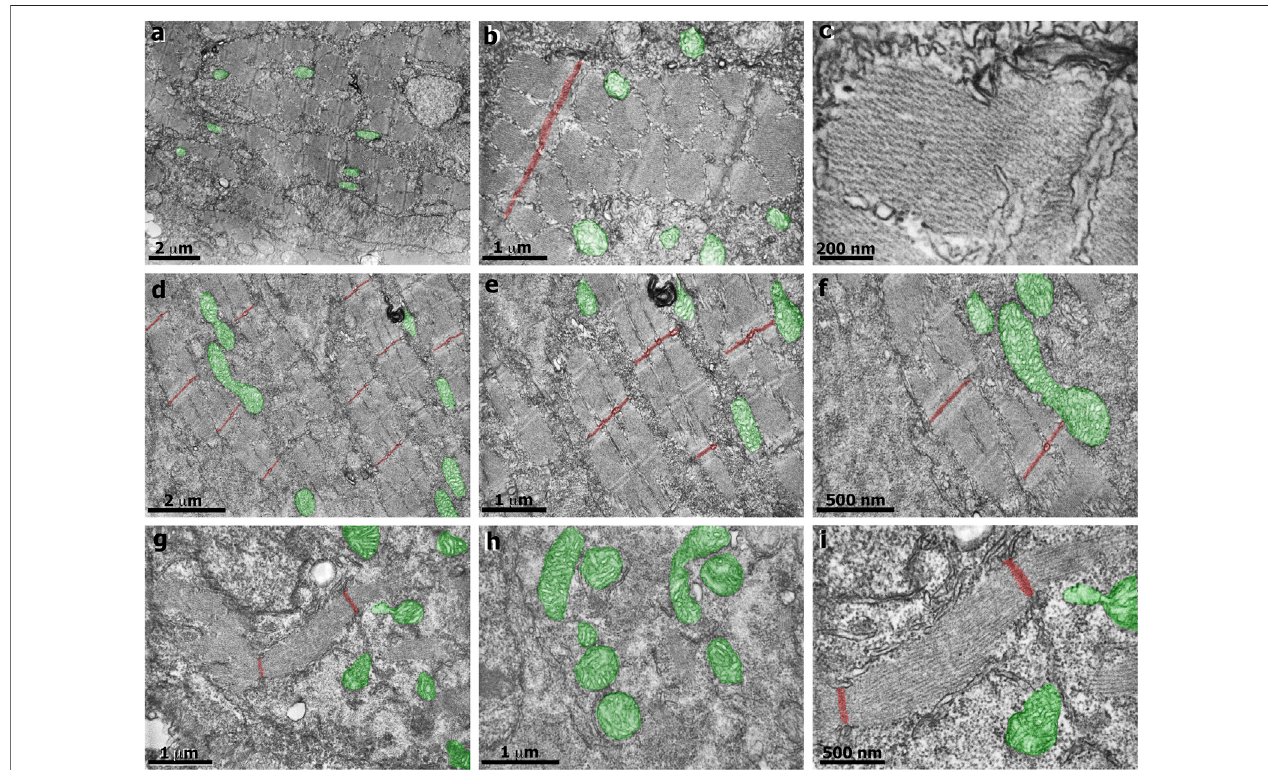
FIGURE 2 | Transmission electron microscopy of zebra fi sh embryos treated with simvastatin. Control untreated zebra fi sh embryos (A – C) present organized bundles of myo fi brils and exhibit well-preserved mitochondria (green). Note that the Z lines (red) are aligned and periodically spaced. The sarcomeric organization is better visualized in fi gure (C) . In the mild phenotype of simvastatin-treated embryos (D – F) , myo fi brils are well-organized, and the alignment of Z lines is preserved. In the severe phenotype of simvastatin-treated embryos (G – I) , myo fi brils are not aligned, vacuoles are observed (G) , as well as a higher number of mitochondria (green). Scale (A,D) 2 μ m; (B,E,G,H) 1 μ m; (C) , 200 nm; (F,I) , 500